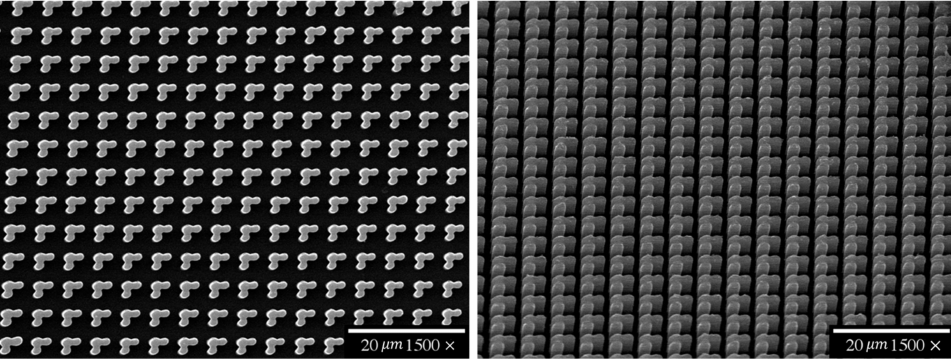
Figure 5. Top view ( left ) and inclined view ( right ) of PFBT/SU-8 structures patterned by two-photon lithography (PFBT:SU-8 ratio 1:40, 30% solid content of SU-8 in